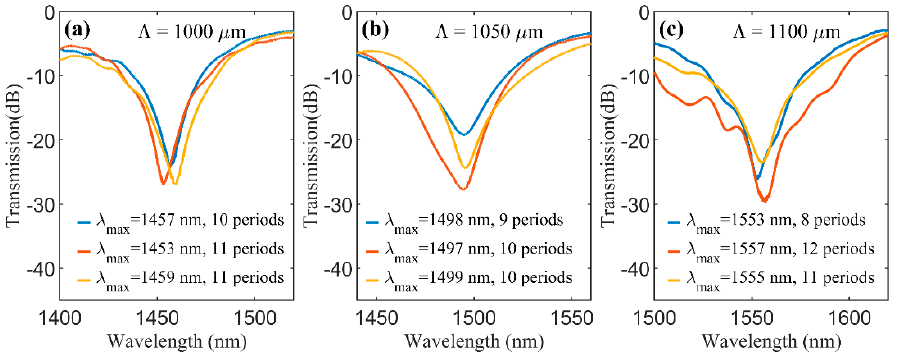
Figure 2. Transmission spectra of the produced long period gratings (LPGs) with periods ( a ) 1000, ( b ) 1050 and ( c ) 1100 µm.